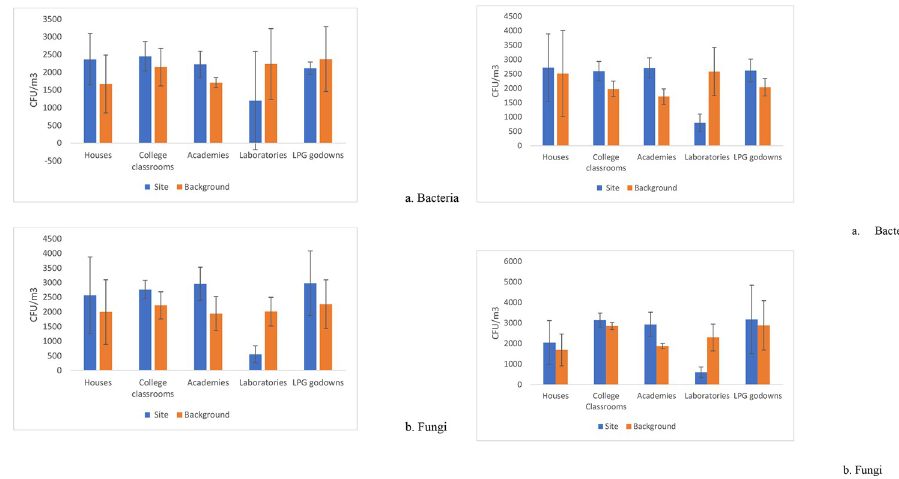
Fig 3. a: Average microbial concentrations of bacteria and fungi during winter season (December-February 2018– 2019) Error bars show customized standard deviation. b: Average microbial concentrations of bacteria and fungi during spring season (Mar-May 2019) Error bars show customized standard